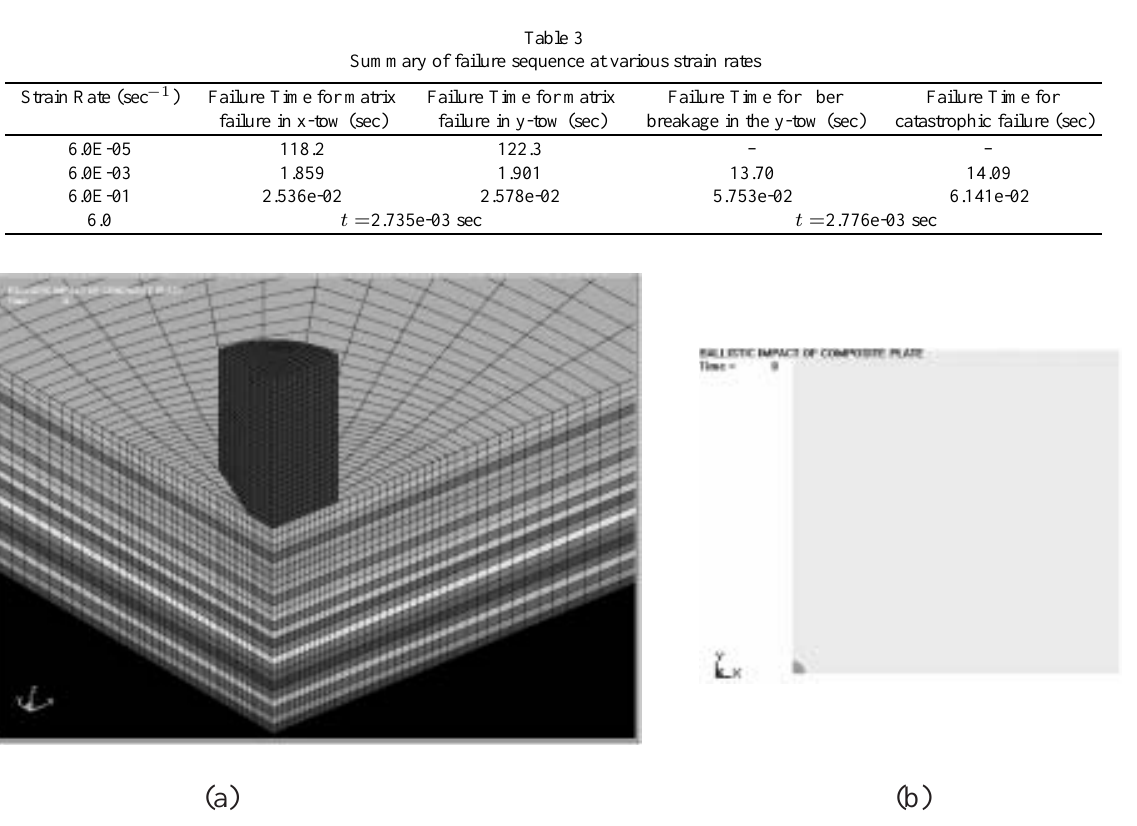
Fig. 6. LSDYNA-model for a quarter scale plate/projectile system: (a) Close-up view of contact zone; and (b) top